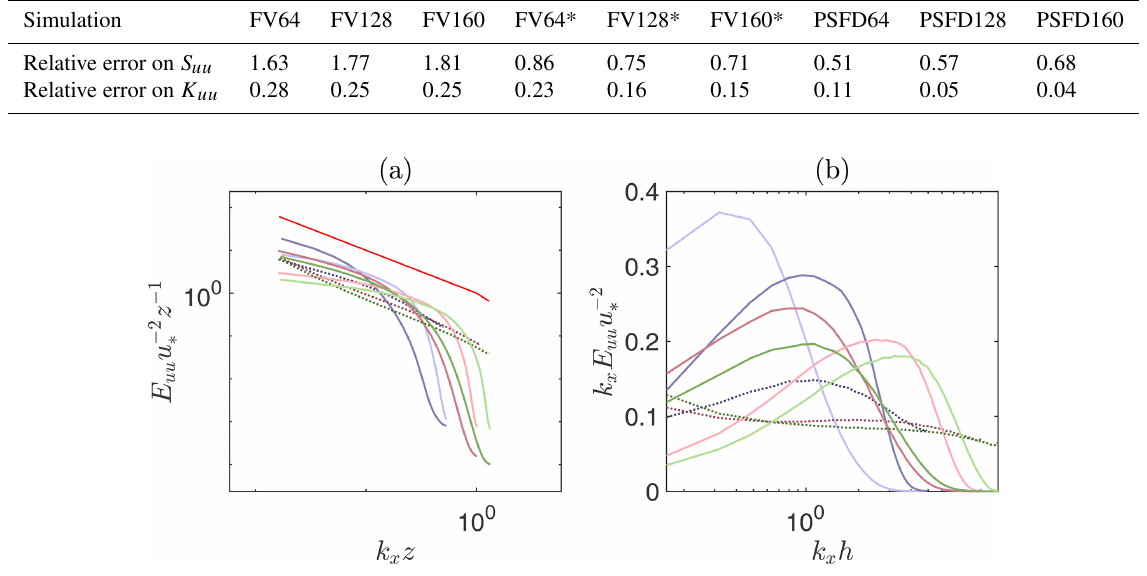
Table 3. Relative error on skewness || S uu − S uu, meas || L 2 / || S uu, meas || L 2 and kurtosis || K uu − K uu, meas || L 2 / || K uu, meas || L 2 w.r.t. the mea-